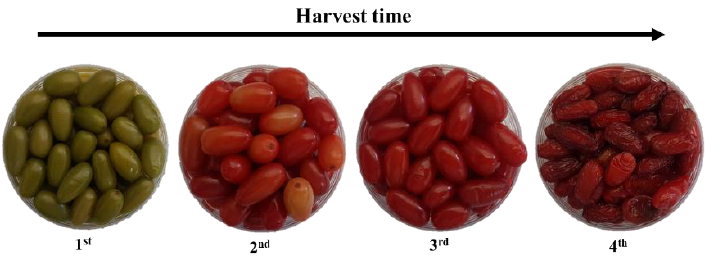
Figure 1. Harvest times of Cornus officinalis fruits. First, 15 September; second, 15 October; third, 15 November; fourth, 15 December (2020). Table 1. Sample preparation.